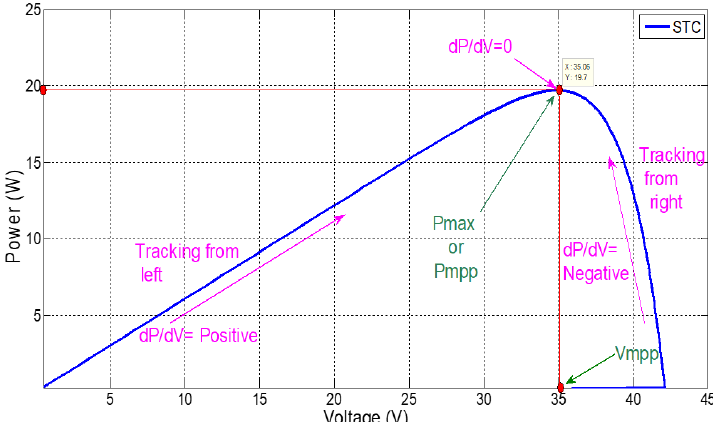
Table 1. Methodology of P&O technique [23].